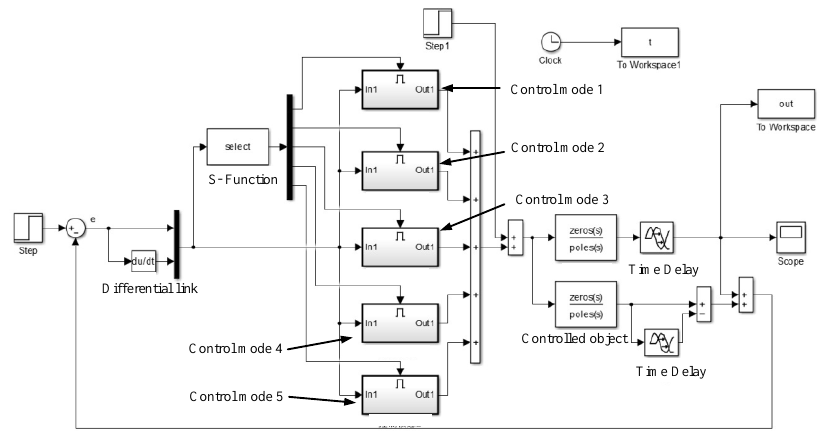
Figure 6. Steering system human-simulated control system based on MTLAB/Simulink.